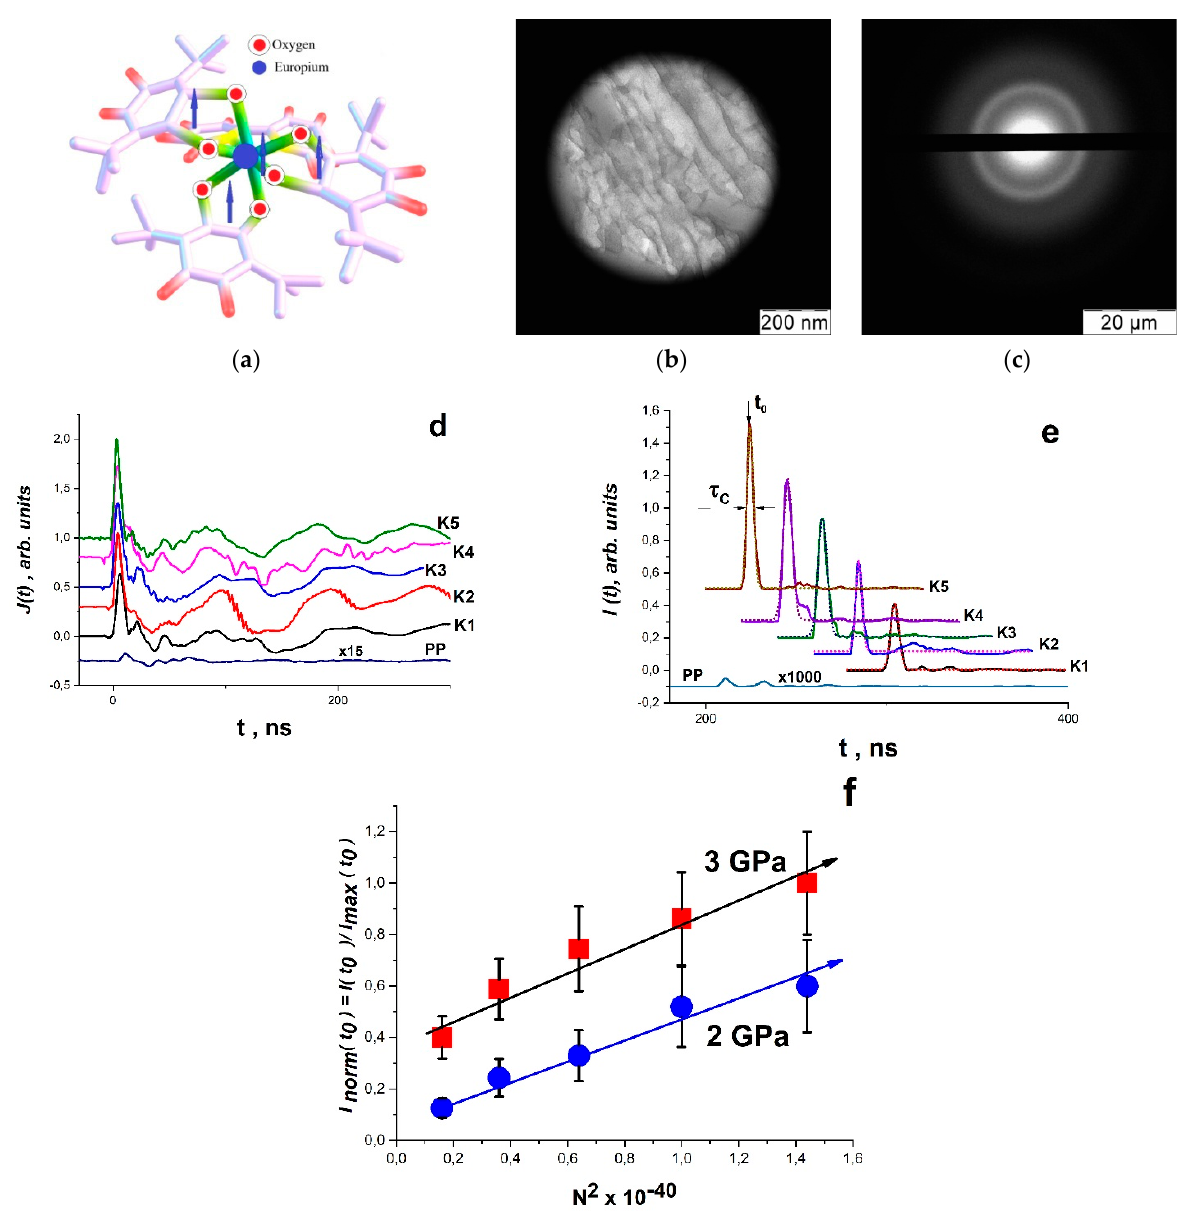
Figure 9. ( a ) structure of Eu(III)(SQ) 3 · bipy complex; ( b ) microphotograph and ( c ) electronogram of composite sample K5 ( PS –Eu(III)(SQ) 3 · bipy) before mechanical activation; ( d ) time scan of normalized signals J ( t ) for composites K1, K2, K3, K4 and K5 and PS ; ( e ) time sweep of normalized signals I ( t )~[ E ( t )] 2 for composites K1, K2, K3, K4 and K5 and PS ; ( f ) normalized dependence I ( t 0 ) on the